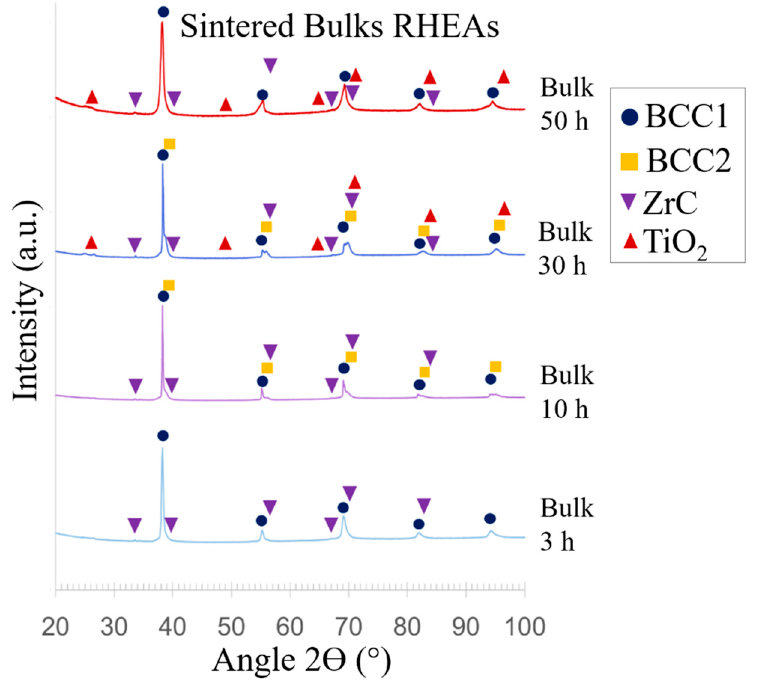
Figure 5. XRD patterns of sintered bulks using powders subject to different times of milling. The sintered bulk using feedstock powders milled for 3 h shows a main BCC1 phase and a small fraction of carbides, belonging to the crystal structure of ZrC, space group Fm-3m (ICSD Coll. Code 26954). On the other hand, when the bulks are prepared from 10 h milled powders, they exhibit two BCC phases, instead of one. These are called BCC1 and BCC2. This is evidenced by the additional peaks of BCC2 in very close angles from those of BCC1—thus demonstrating very close lattice parameters to the ones of BCC1. The exact lattice constants of each phase are found in Table